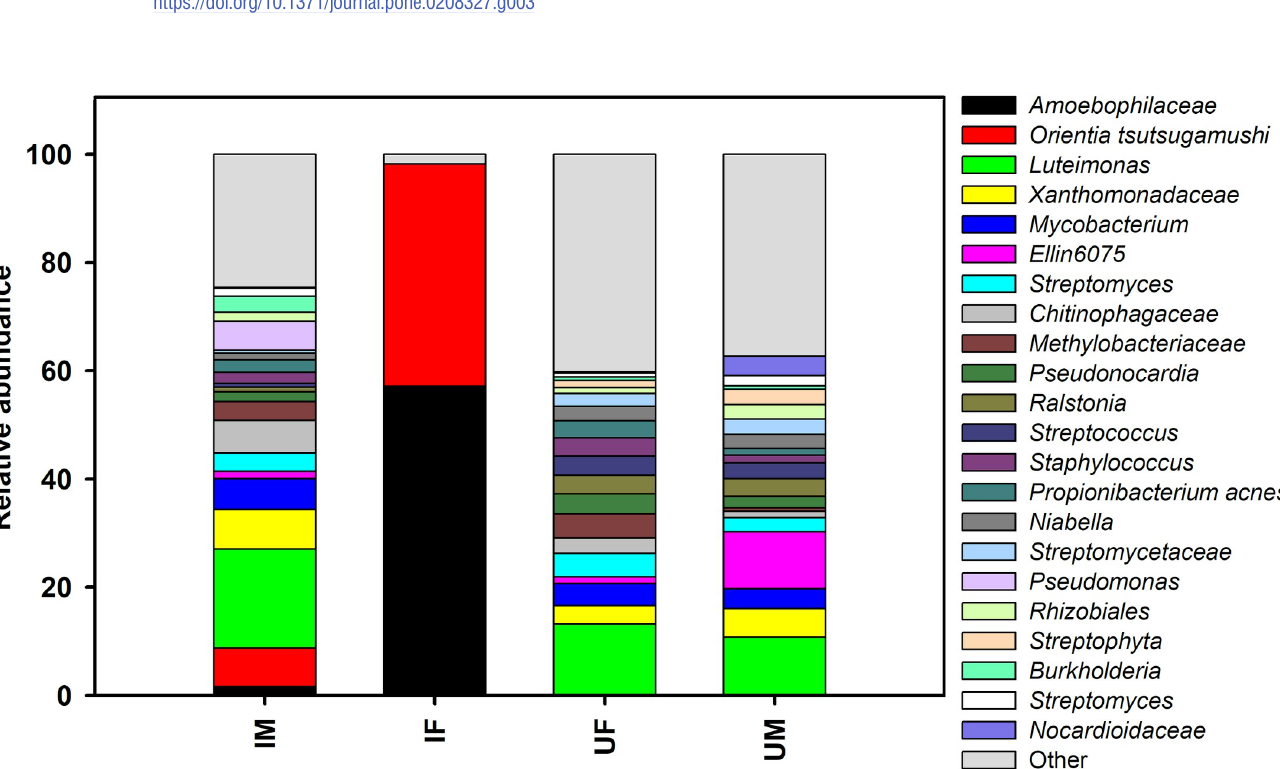
Fig 4. Relative abundance of major bacteria in infected and uninfected male and female mites at the genus level. Bars show proportions of each taxa. ‘Others’ group shows all genera with relative abundance below 1% over the total number of reads. Abbreviations: IF, infected females; IM, infected males; UF, uninfected females; UM, uninfected